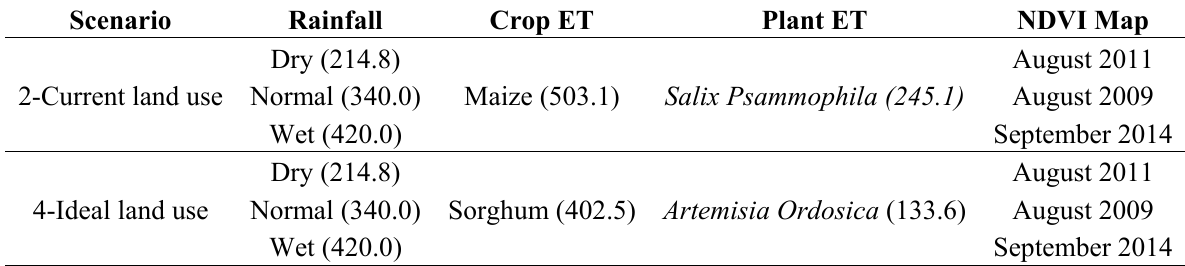
Table 2. Precipitation and ET values for reference crops and plants for scenarios 2 and 4